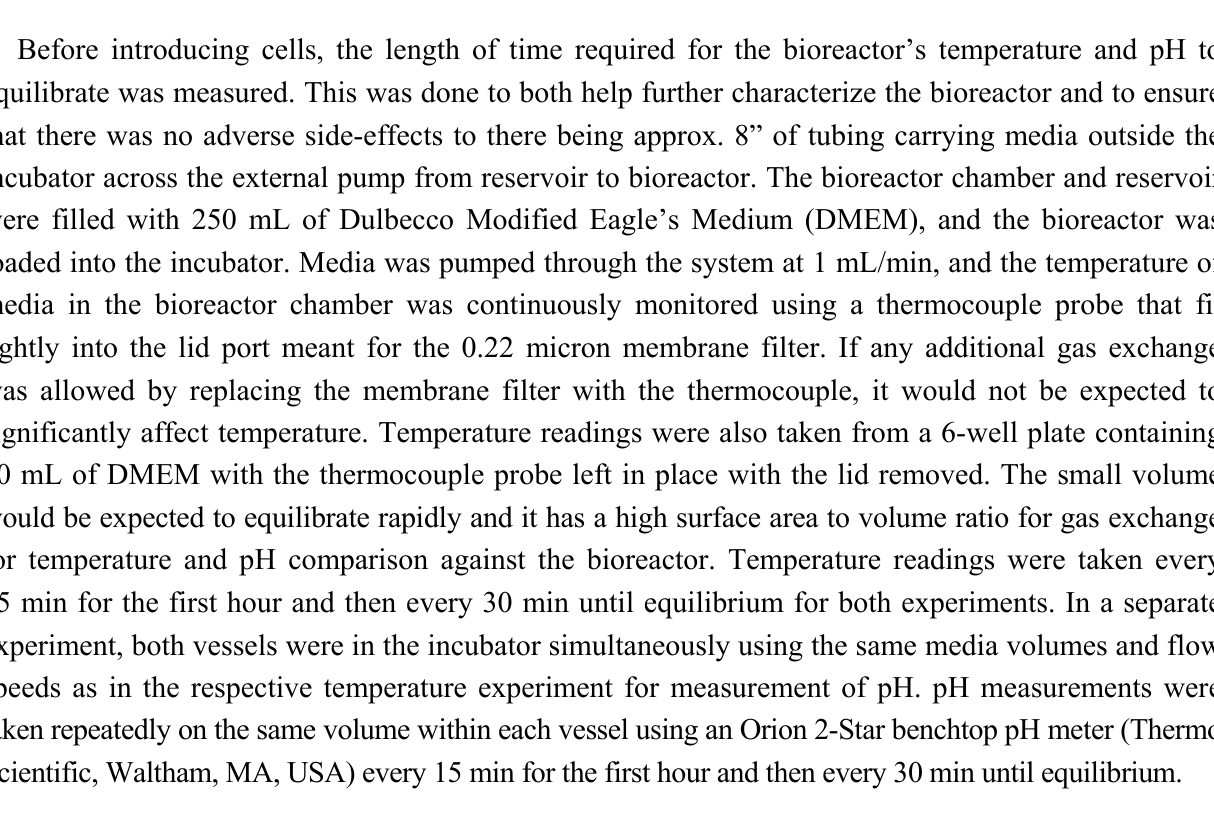
Figure 2. Cross-sectional diagram of the bioreactor chamber depicting the position of the transwell insert within the